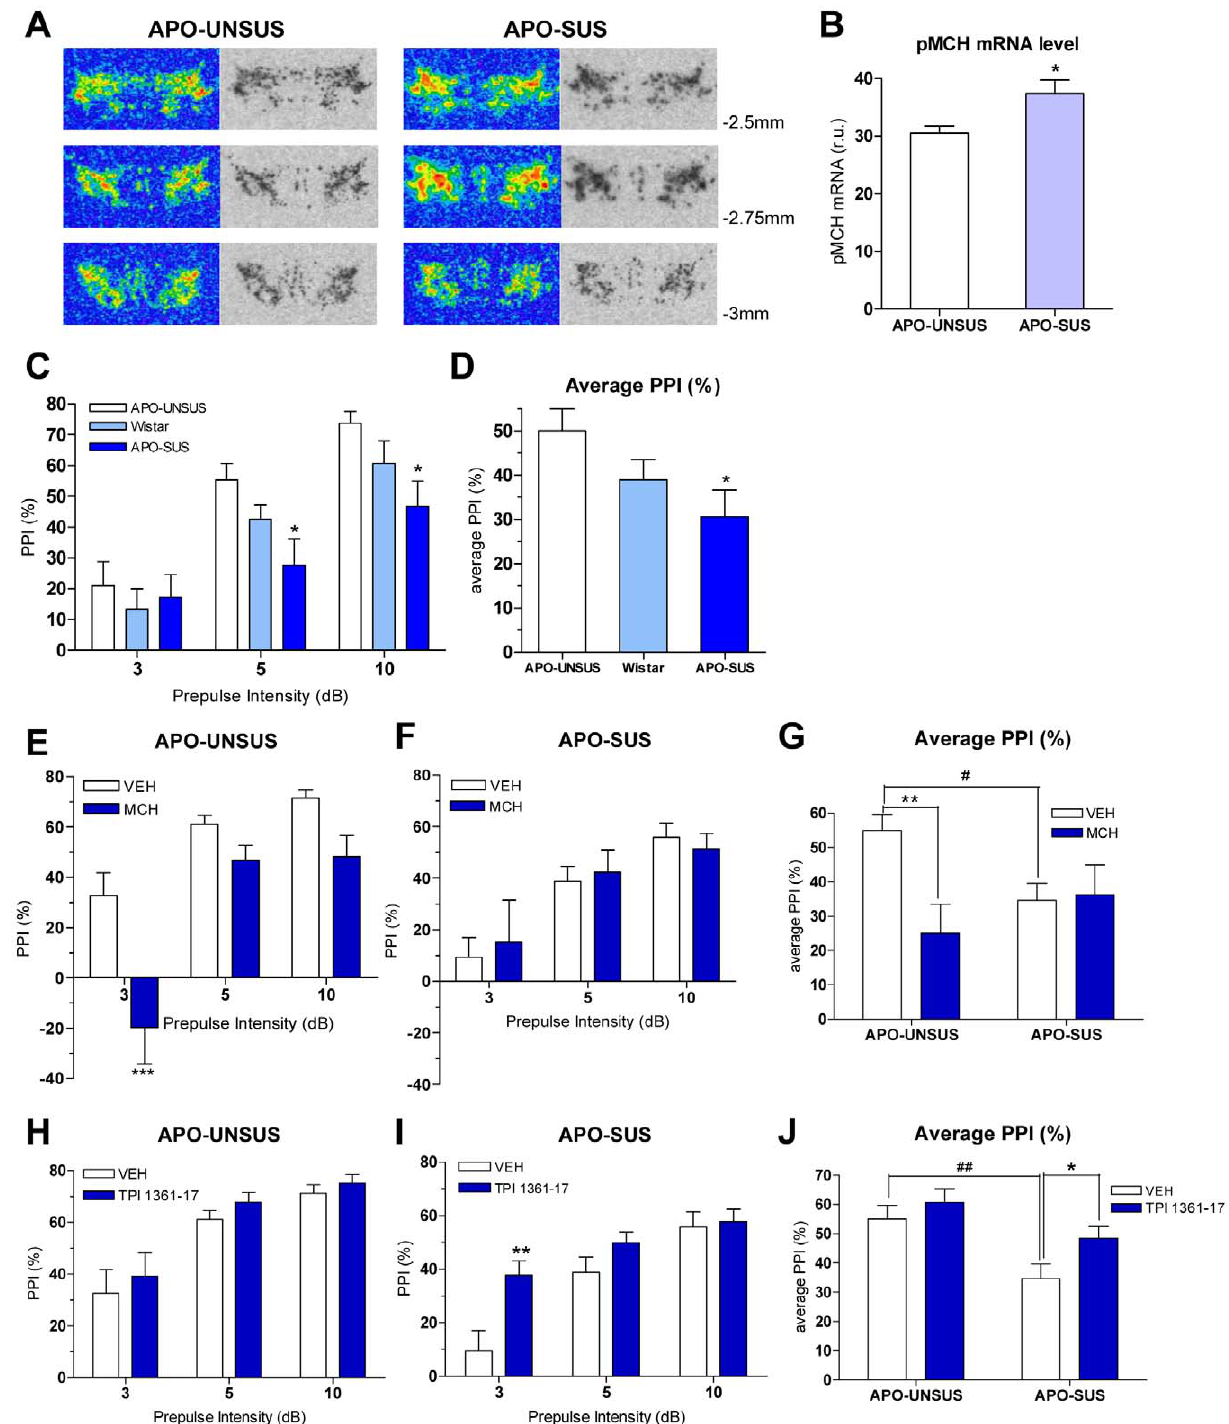
Figure 3. MCH effects on PPI in APO-UNSUS and APO-SUS rats. A. Autoradiographic images illustrating the pMCH expression patterns in hypothalamic areas of APO-UNSUS and APO-SUS rats approximately at 2 2.5, 2 2.75 and 2 3 mm from bregma. B. pMCH mRNA levels in the lateral hypothalamus (LH) at 2 2.75 from bregma of APO-UNSUS and APO-SUS rats (* p , 0.05 vs. APO-UNSUS, t-test; n=5). C. PPI levels of naı¨ve APO-UNSUS, wild type Wistar and APO-SUS rats (* p , 0.05 vs. APO-UNSUS, two-way ANOVA with bonferroni test; n=15). Values represent mean % PPI 6 SEM. D. Average PPI level of naı¨ve APO-UNSUS, wild type Wistar and APO-SUS rats (* p , 0.05 vs. APO-UNSUS, one-way ANOVA with bonferroni test; n=15). Values represent average of % PPI upon three prepulse intensities 6 SEM. E. Effect of MCH (10 nmole) on PPI in APO-UNSUS rats (*** p , 0.001 vs. VEH, two-way ANOVA with Bonferroni test; n=10–13). F. Effect of MCH (10 nmole) on PPI in APO-SUS rats (n=10–13). G. Average of PPI values after VEH or MCH (10 nmole) injections in APO-UNSUS and APO-SUS rats (** p , 0.01, # p , 0.05 vs. VEH-treated APO-UNSUS rats, two-way ANOVA with Bonferroni test; n=10–13). H. Effect of TPI 1361-17 (10 nmole) on PPI in APO-UNSUS rats (n=12–13). I. Effect of TPI 1361-17 (10 nmole) on PPI in APO-SUS rats (** p , 0.01 vs. VEH, two-way ANOVA with Bonferroni test; n=13). J. Average of PPI values after VEH or TPI 1361-17 (10 nmole) injections in APO- UNSUS and APO-SUS rats ( ## p , 0.01 vs. VEH-treated APO-UNSUS, * p , 0.05 vs. VEH-treated APO-SUS, two-way ANOVA with Bonferroni test; n=12– 13). Data (E,F,H,I) are expressed as mean % PPI 6 SEM. Data (G,J) represent average of % PPI elicited by three prepulse intensities 6 SEM. doi:10.1371/journal.pone.0019286.g003 PLoS ONE |